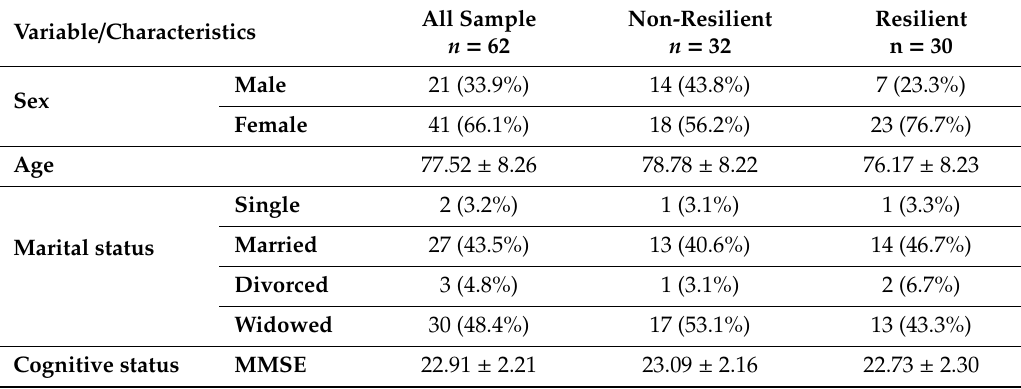
Table1. Meanandstandarddeviation, andfrequencyandpercentageinsociodemographiccharacteristics and cognitive functioning in the whole sample—and each